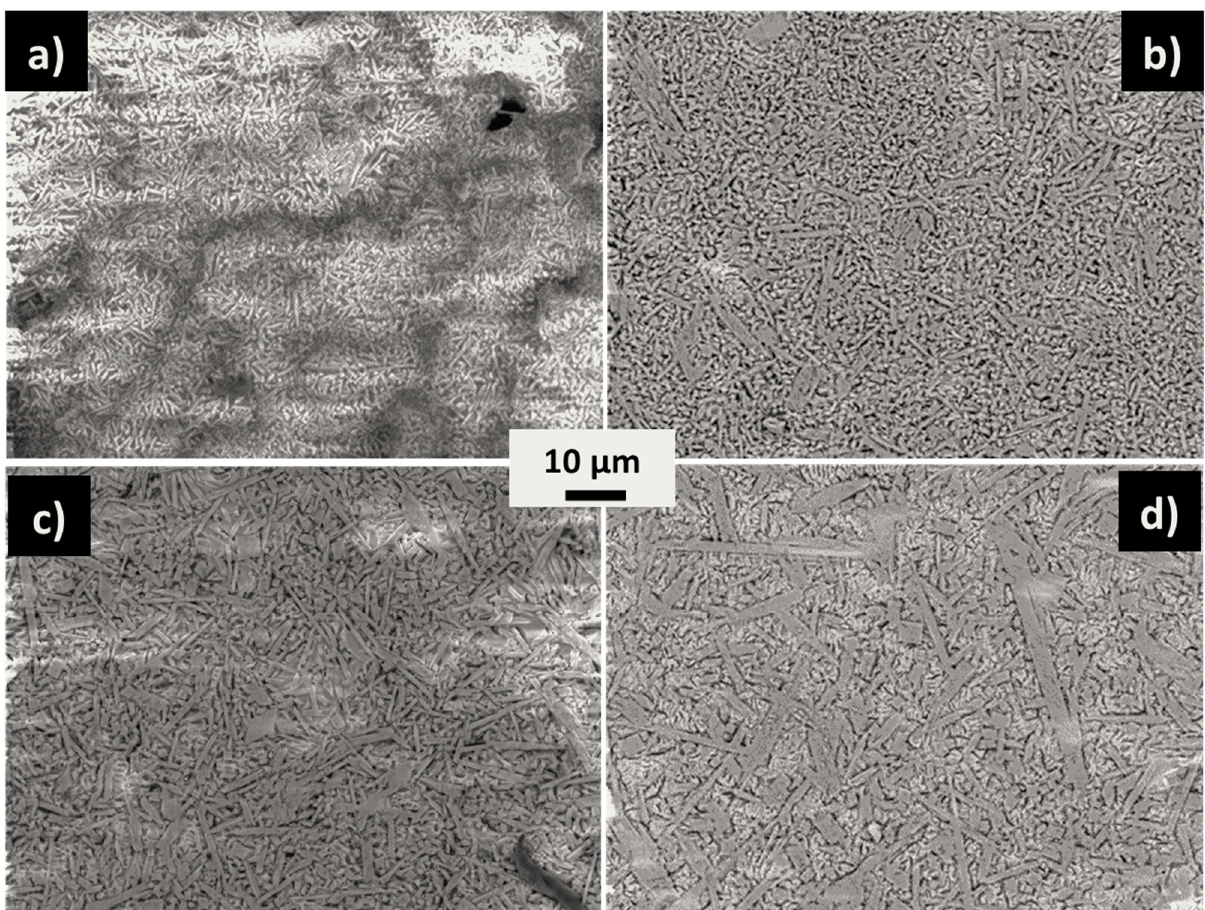
Figure 2. Microstructural variations in pure fly ash 2 samples sintered at 1500 °C for different times ( a ) 1 h, ( b ) 4 h, ( c ) 24 h, and ( d ) 96 h.